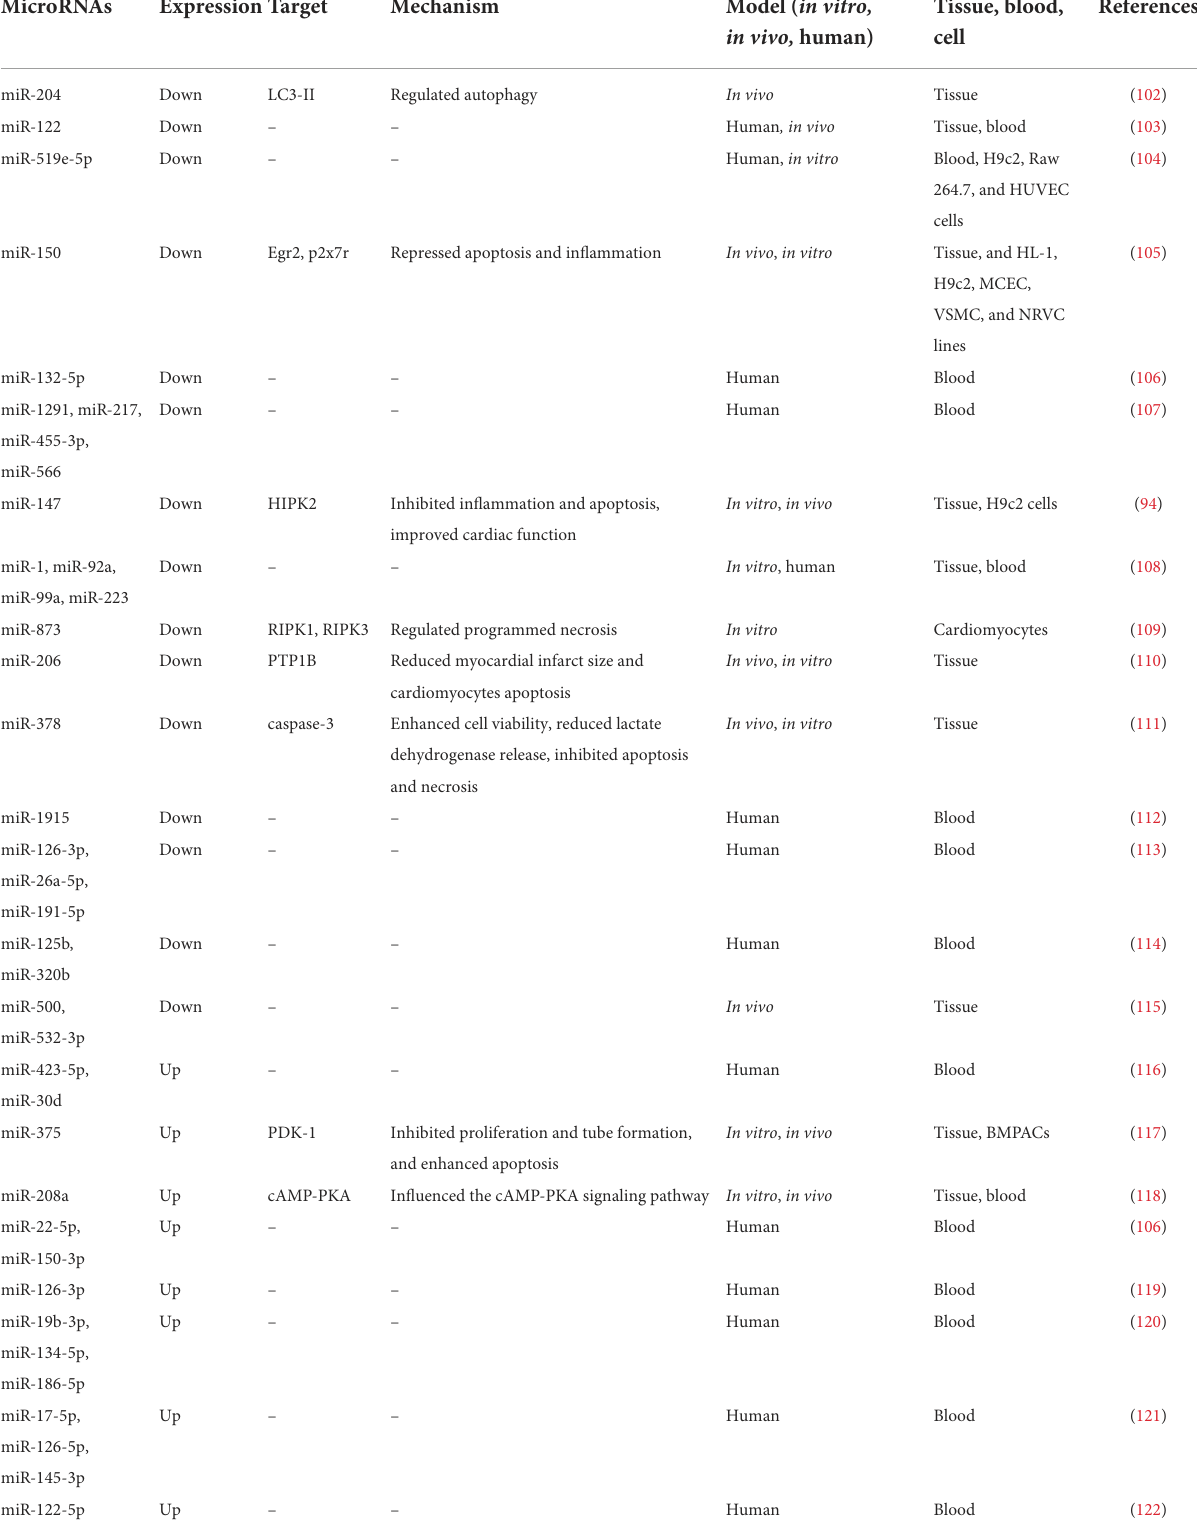
TABLE 1 Reports of changes in miRNA expression in laboratory models and patients with MI.